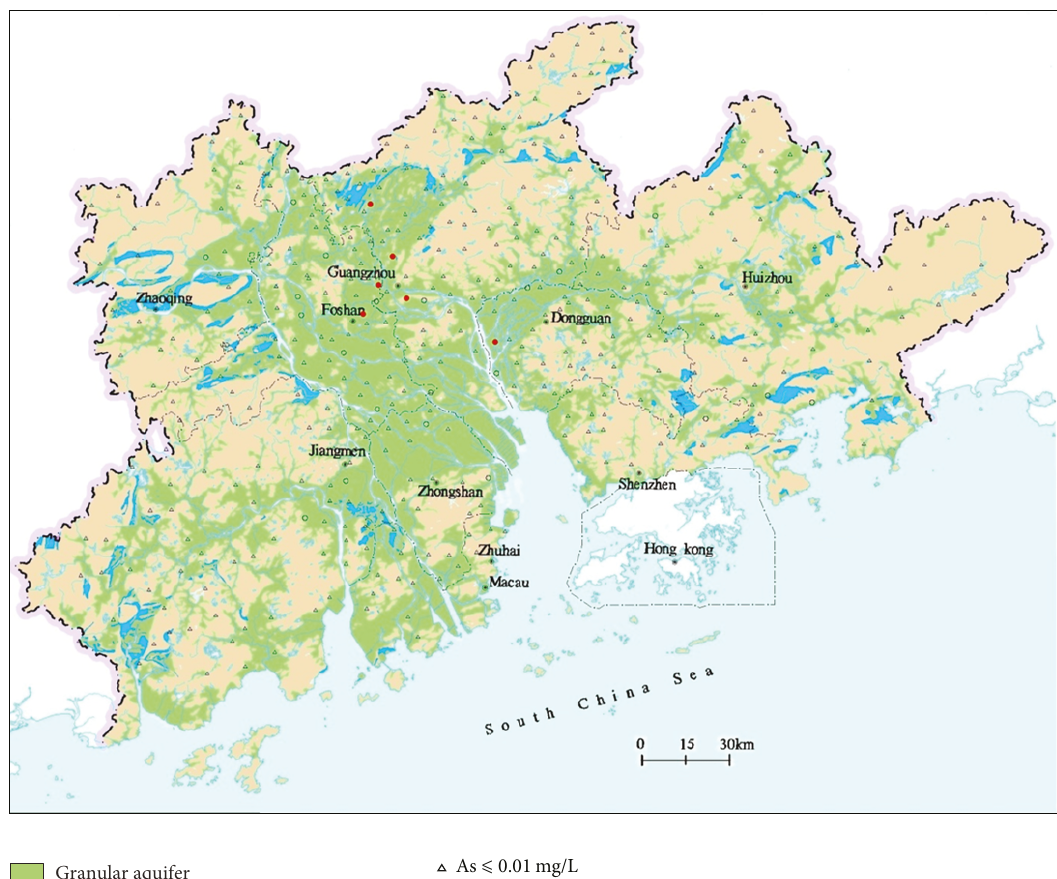
Figure 3: As concentrations in different types of aquifers in the